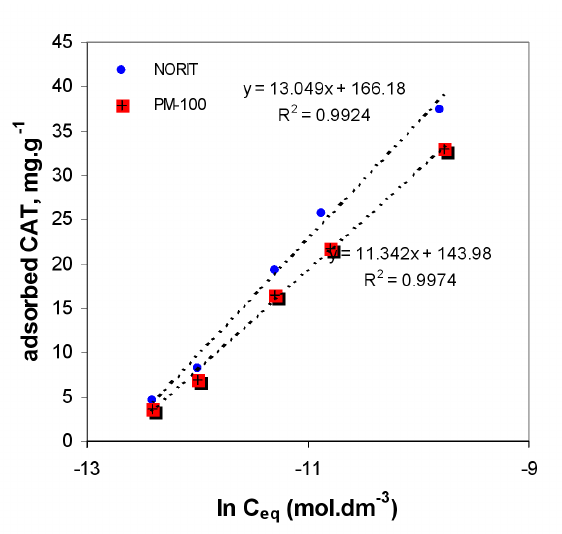
Fig. 2 Dependence of the amount of adsorbed catalase on the logarithm of equilibrium enzyme solution concentration (Tyomkin’s adsorption isotherm) at pH=11.21 and ambient temperature (24 ± 1 ◦ C); adsorbents: activated carbon NORIT (blue) and PM-100 (red). The linear regression equations and the corresponding coefficients of regression are given close to each